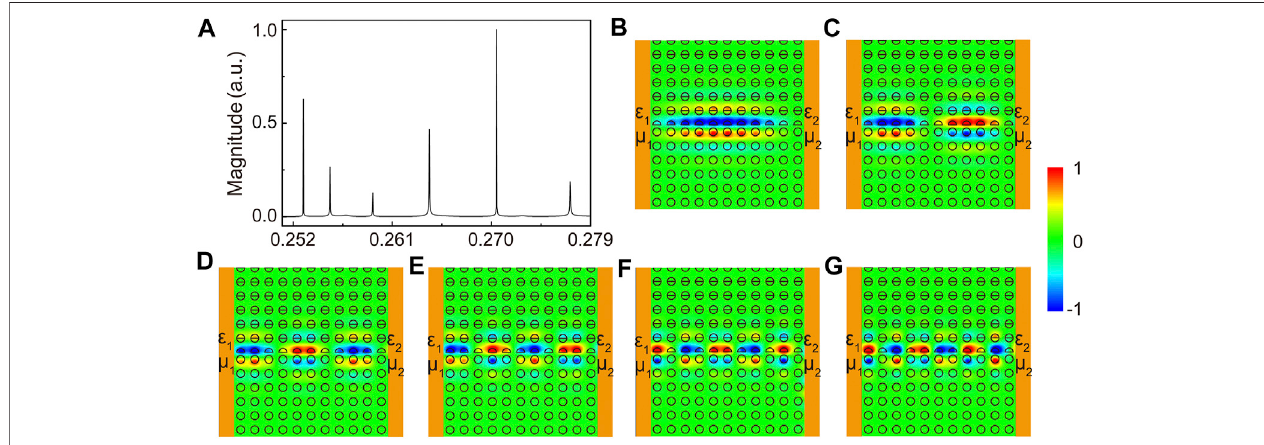
FIGURE3|(A) Thecalculatedtransmissionspectrum withPCmirrorsreplacedbysinglenegativeeffectivemedium slabs. (B – G) Simulated E Z fi elddistributions at 0.2529, 0.2553, 0.2592, 0.2644, 0.2705, and 0.2771 c / a .